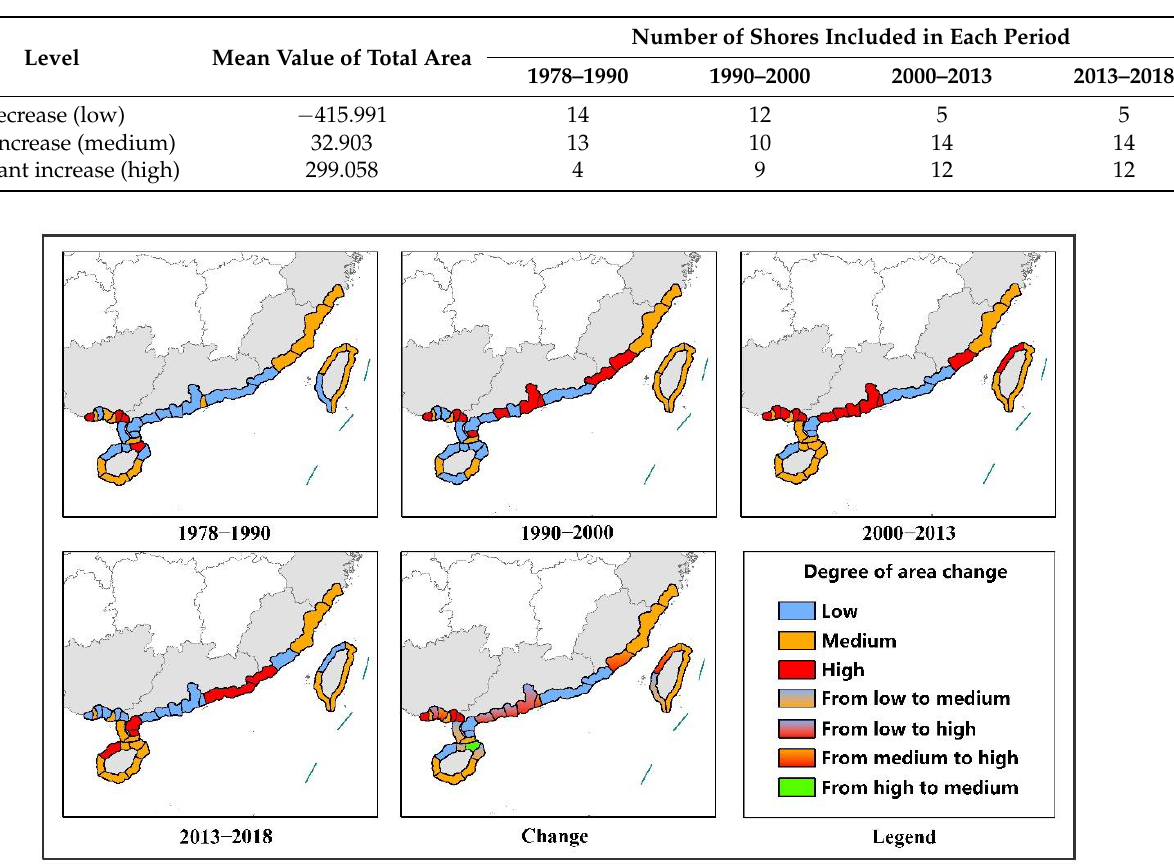
Table 5. Change in the level of the total area and the number of shores included.